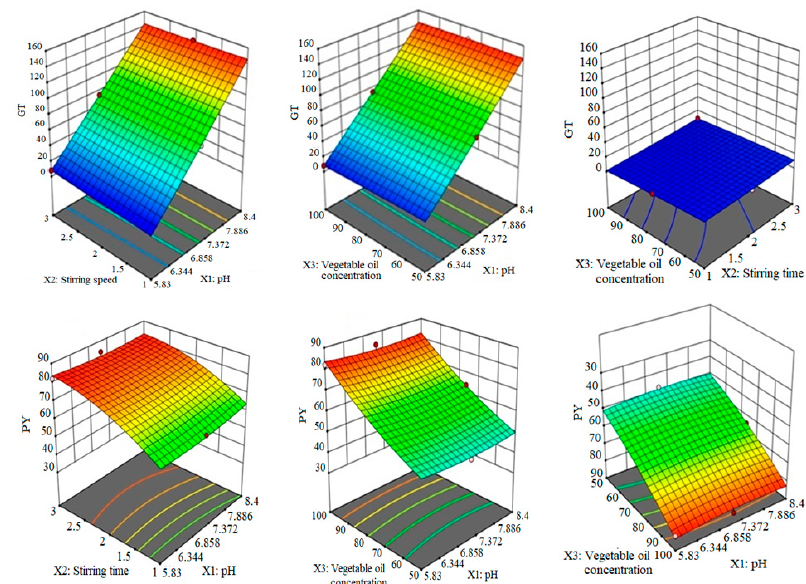
Figure 1. The 3D surface plots indicating the cumulative impact of stirring time, pH, and vegetable oil concentration on GT and PY.